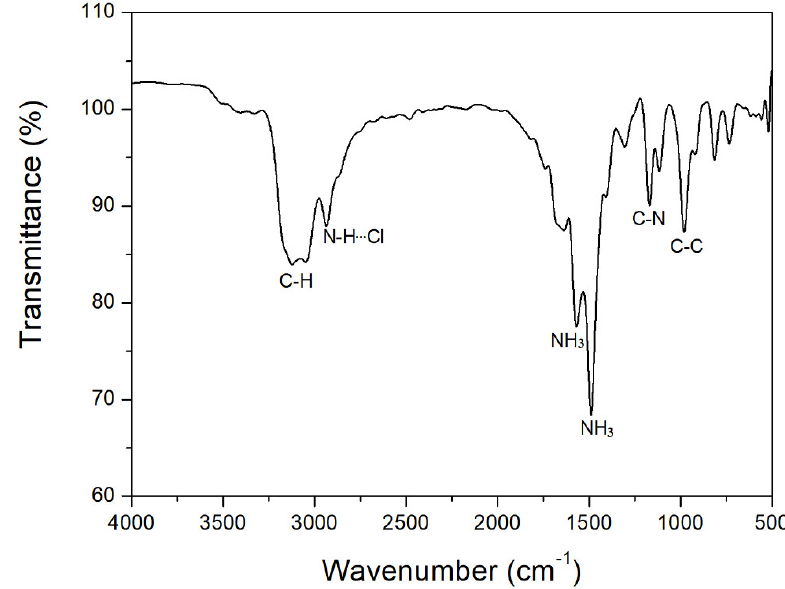
Figure 2. FT – IR spectrum of [NH 3 (CH 2 ) 5 NH 3 ]MnCl 4 at 300 K.